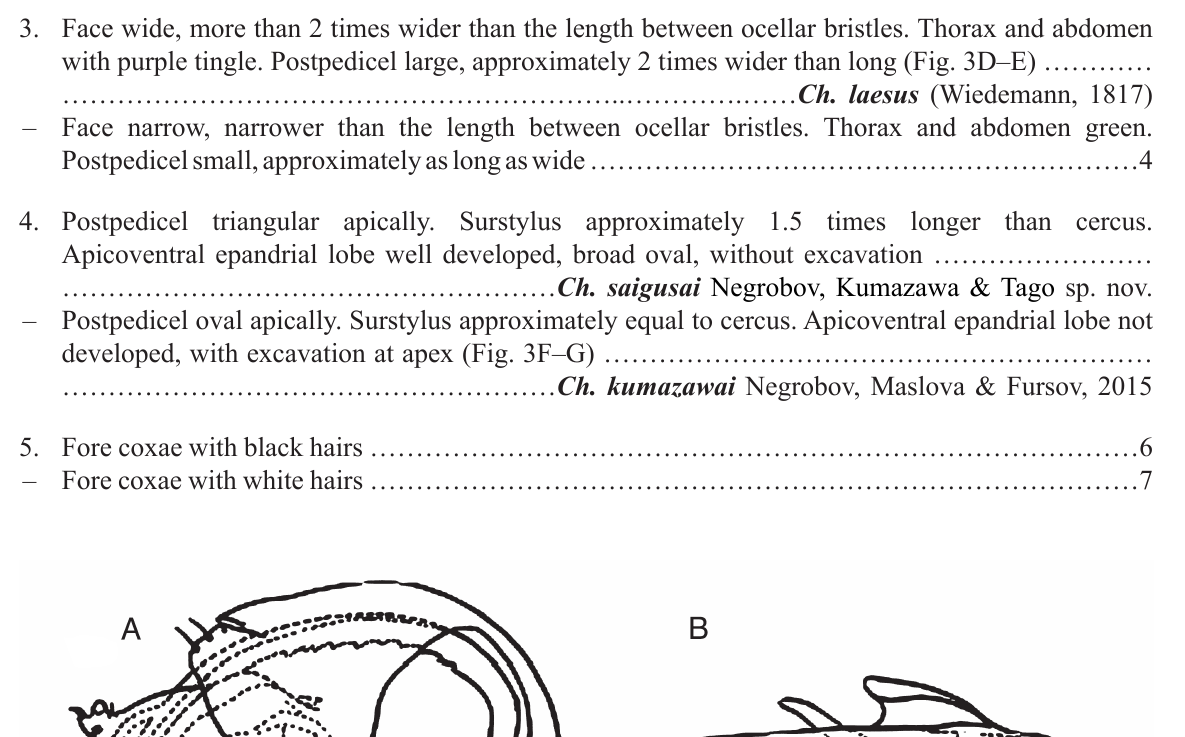
Postpedicel oval apically. Surstylus approximately equal to cercus. Apicoventral epandrial lobe not